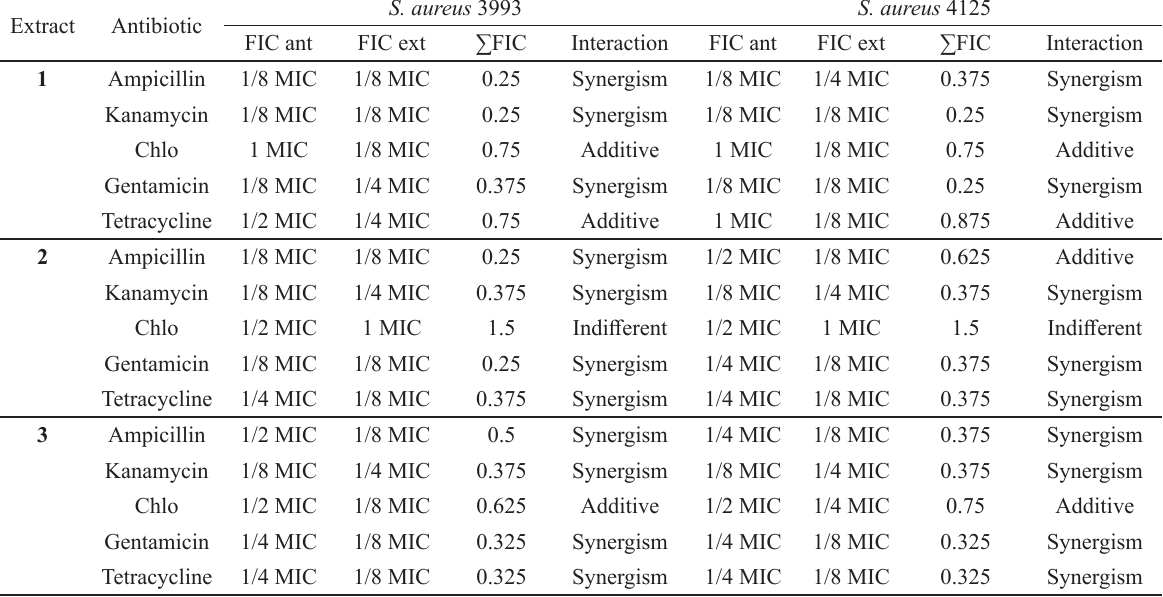
Interaction between plant extracts and antibiotics on Staphylococcus aureus strains.